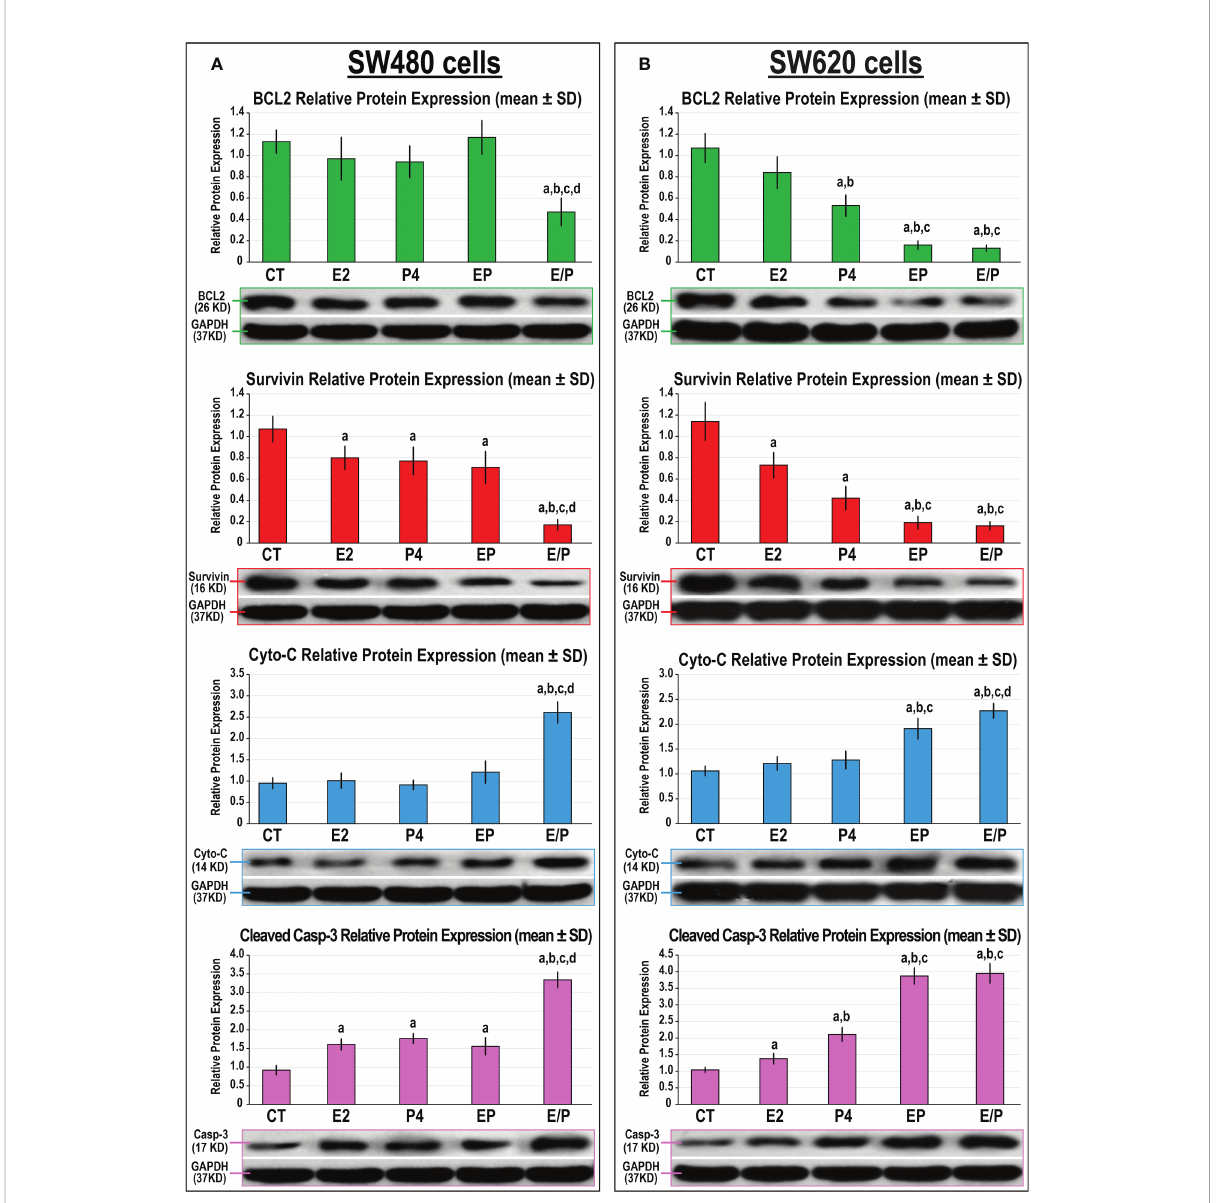
FIGURE 7 Detection of BCL2, survivin Cytochrome C and cleaved caspase-3 proteins by Western blot alongside their relative protein expression (mean ± SD) following the different treatment protocols with E2 and/or P4 for 48 hours in the (A) SW480 and (B) SW620 male colon cancer cell lines (mean ± SD; a P< 0.05 compared with the CT group; b P< 0.05 compared with the E2 monotherapy group; c P< 0.05 compared with P4 monotherapy and d P< 0.05 compared with EP concurrent dual therapy